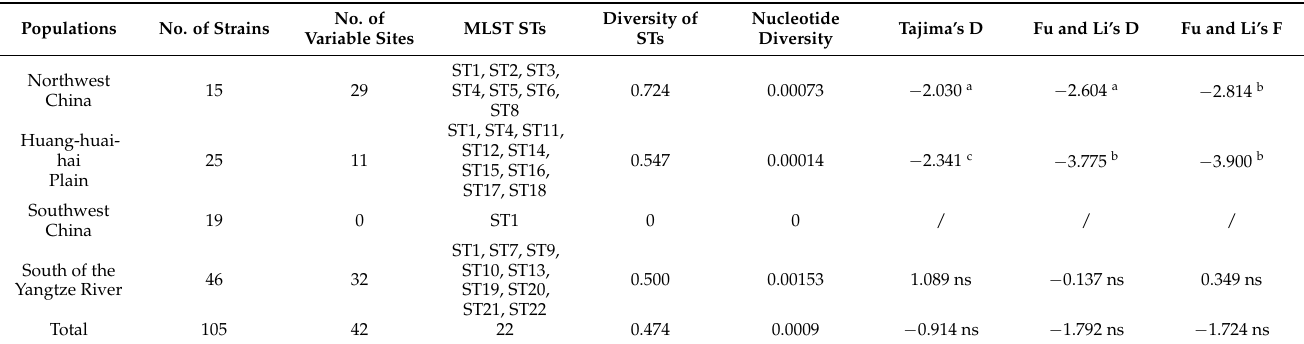
Table 3. Genetic diversity analysis of multi genes in different